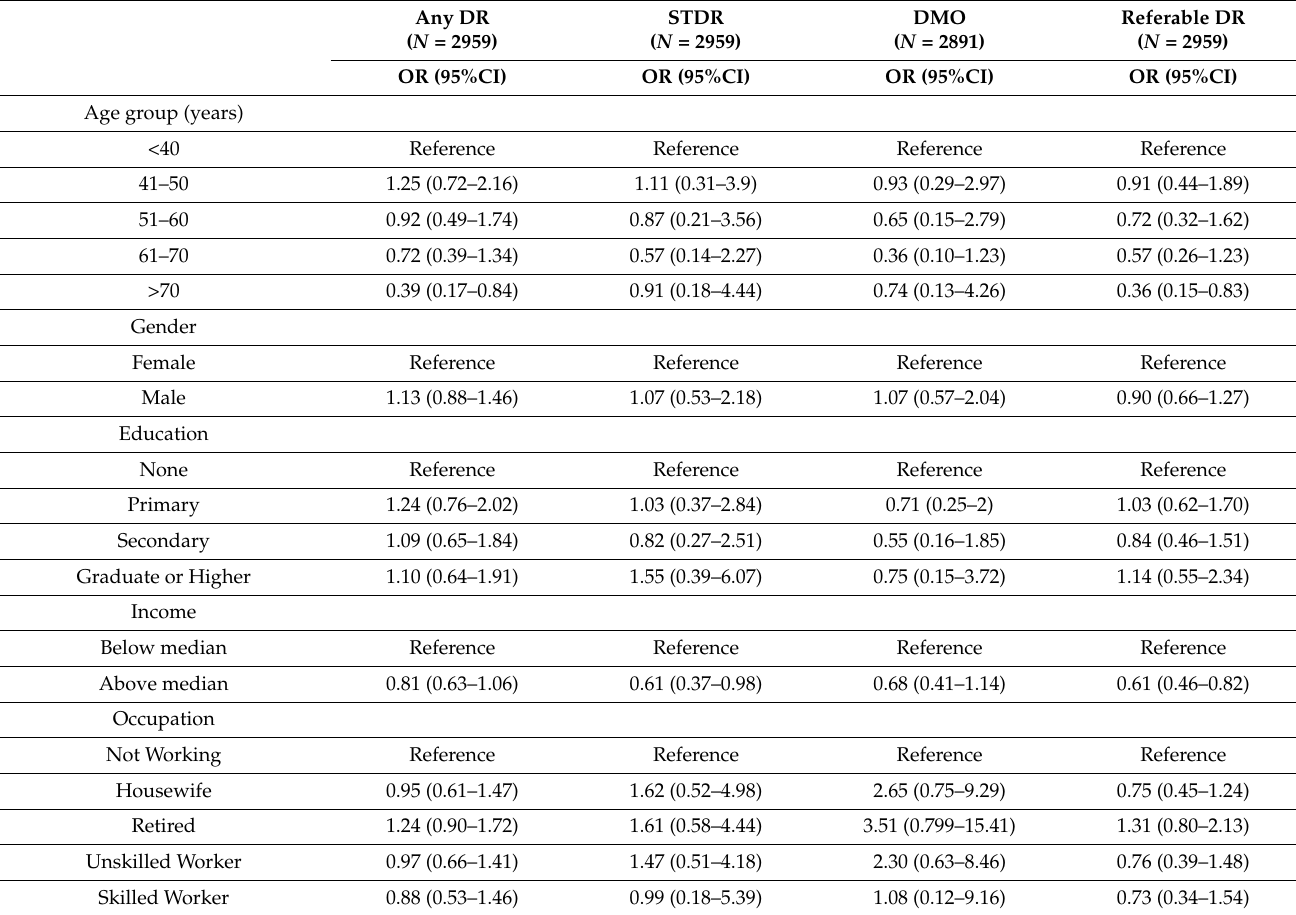
Table 7. Associations of DR with mutually adjusted socio-demographic and diabetes-related factors ( N = 5307).